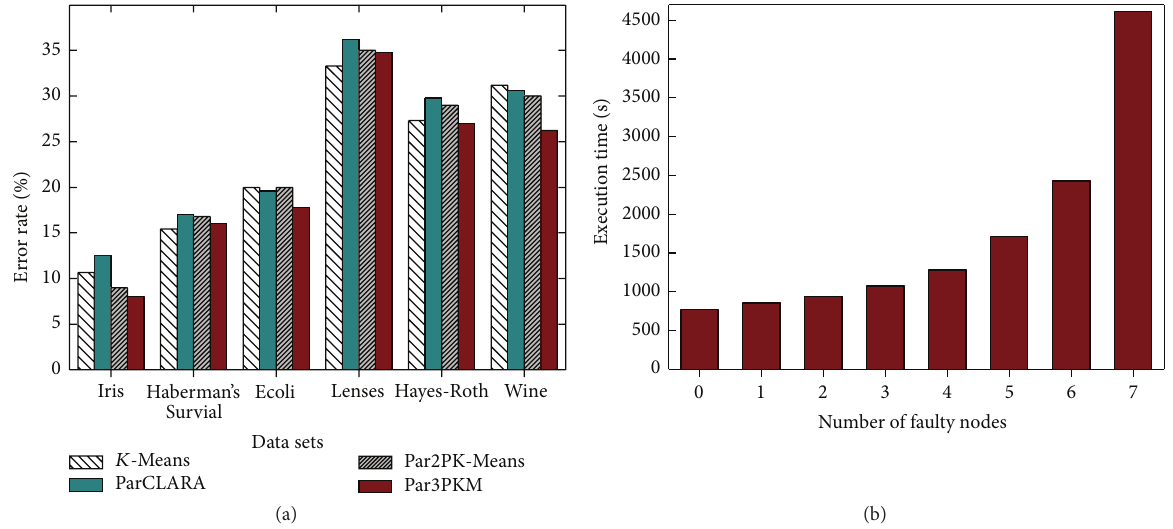
Figure 12: Accuracy and reliability. (a) Accuracy comparison of Par3PKM, Par2PK-Means, and ParCLARA on different data sets and (b) reliability of